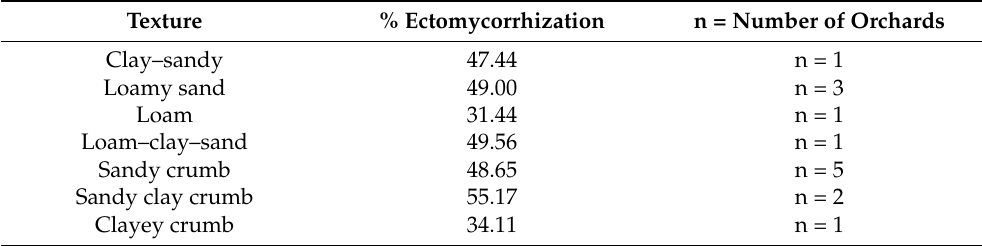
Table 2. Rhizospheric soils in 14 pecan orchards grouped by texture. Chihuahua, Mexico 2020.